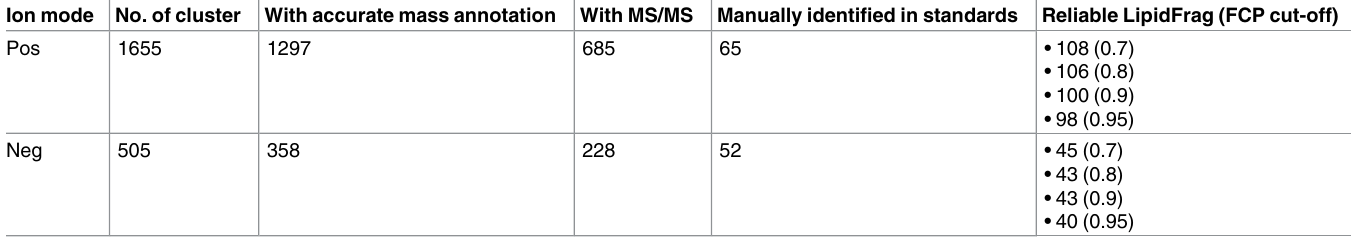
Table 4. Overview on lipid MS1 featuresdetected in C . elegans samples in the two respective ion modes with reliable LipidFrag